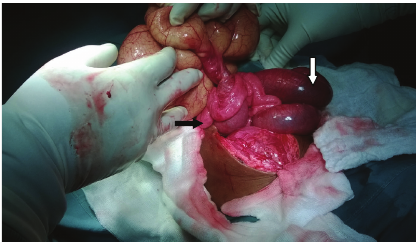
Figure 2: The pedicle of the cyst with proximal intestine dilation (white arrow) and distal intestine collapse (black arrow).